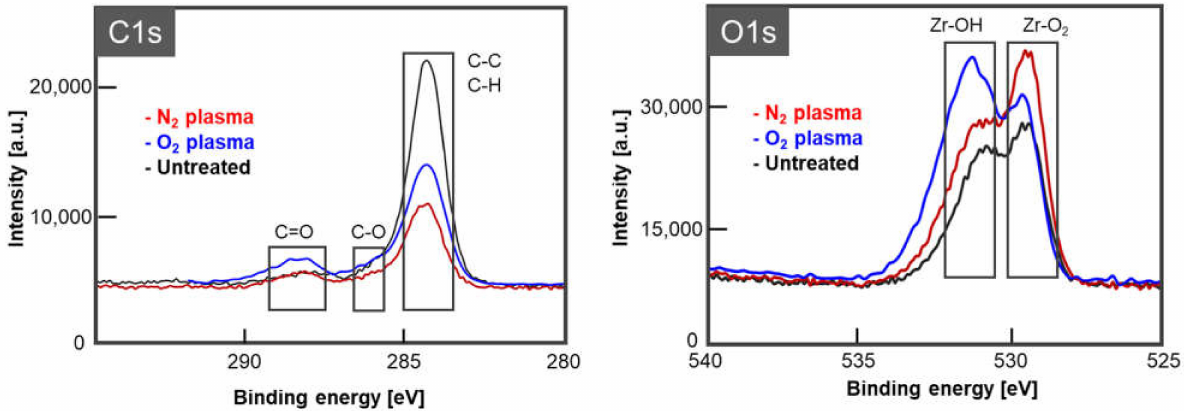
Figure 6. Zirconia surface state after plasma treatment with N 2 and O 2 gases: XPS spectra of C1s and O1s. XPS: X-ray photoelectron spectroscopy; Zr: